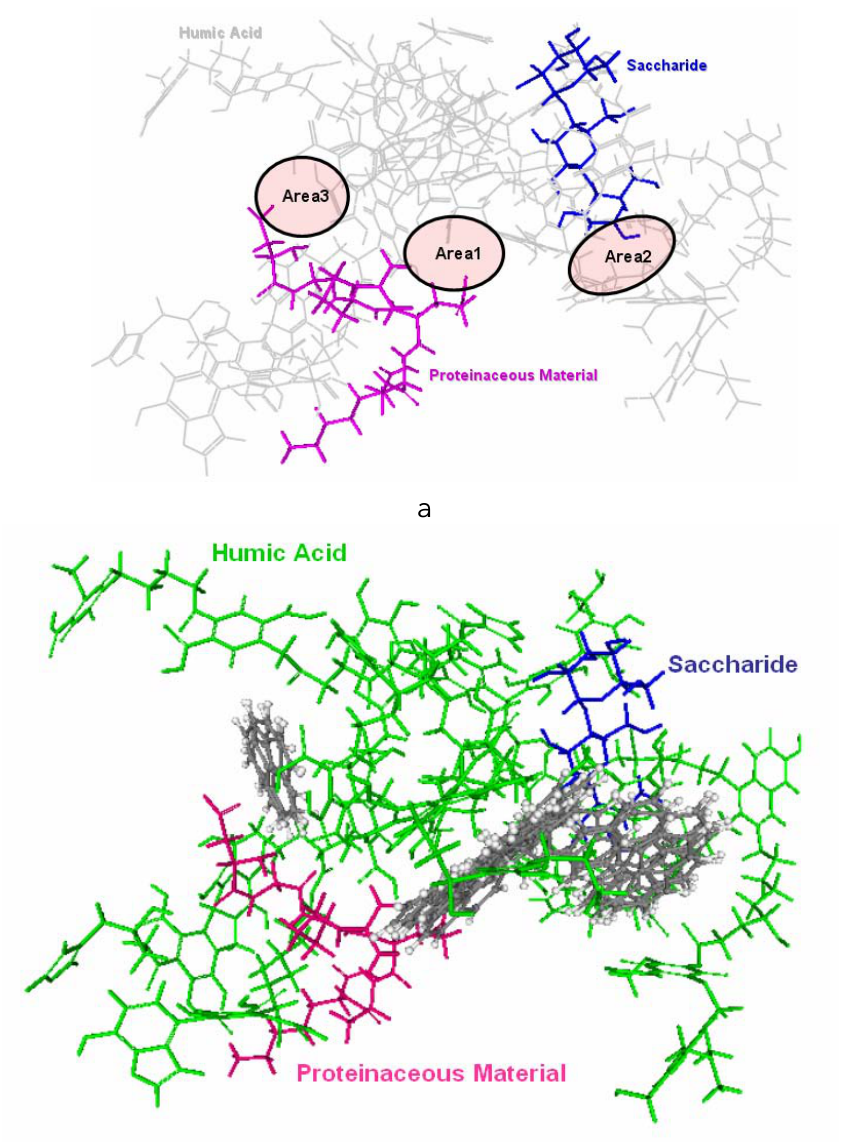
Figure 8 . Binding sites (a) and orientation (b) of docked PAHs onto